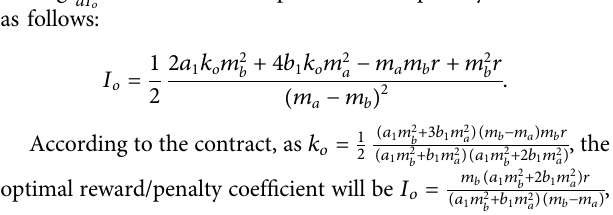
TABLE 6 | Parameters of the numerical